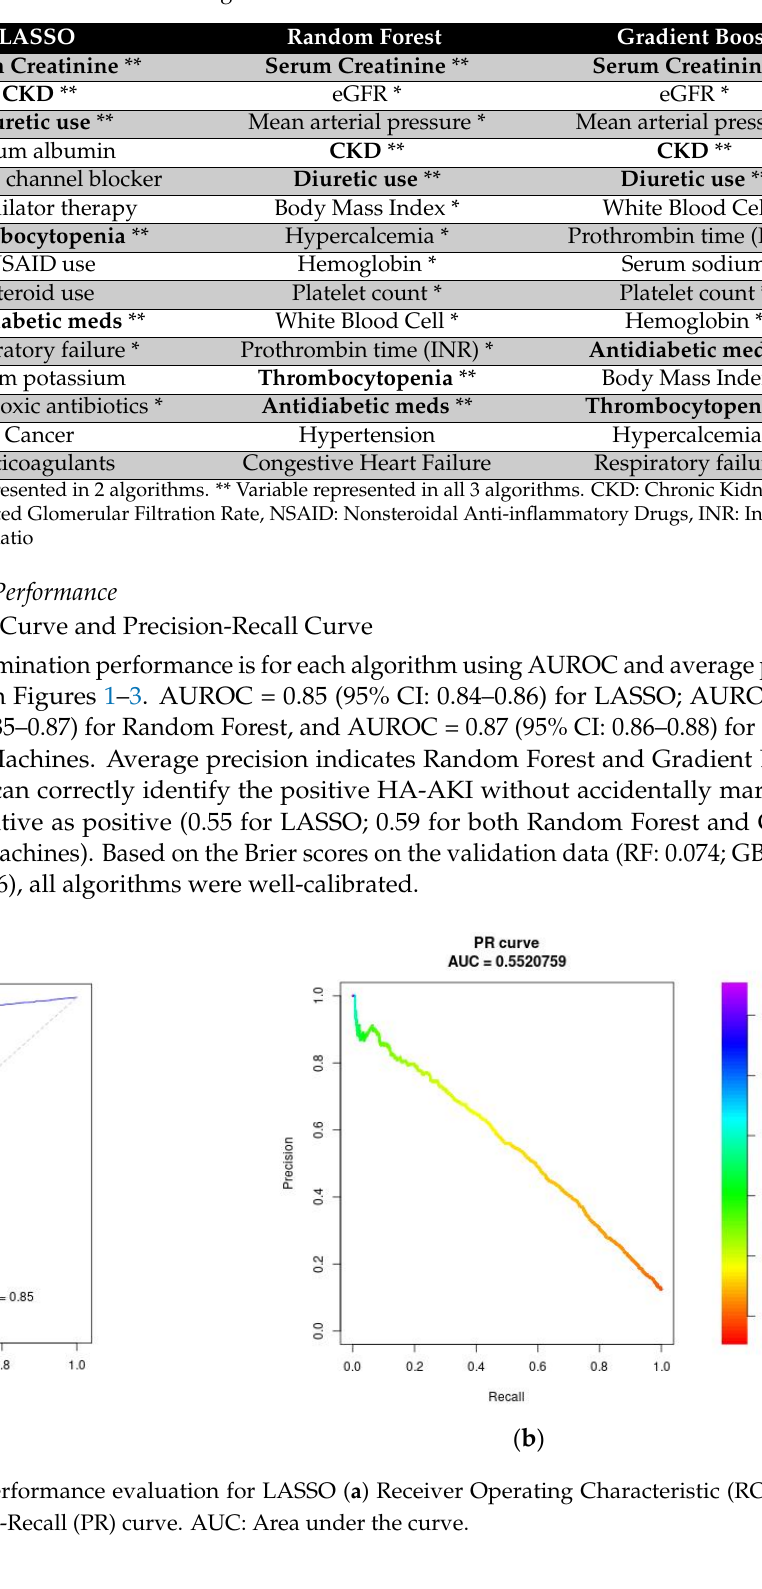
( b ) Figure 2. Performance evaluation for Random Forest ( a ) ROC curve; ( b ) Precision-Recall curve.